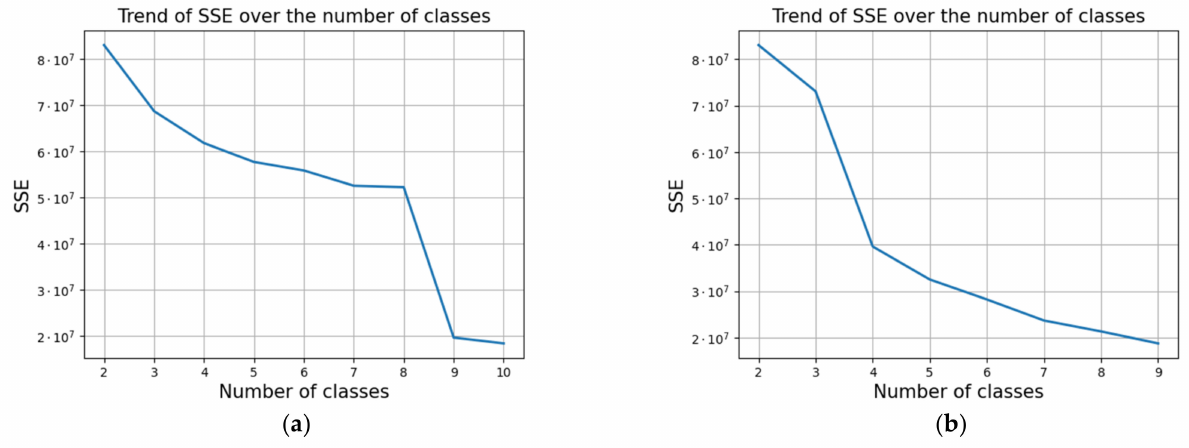
Figure 8. ( a ): estimation of number of clusters on data ranging from 2 to 10 classes using automatic initialization of centroids. ( b ): estimation of number clusters ranging from 2 to 10 classes using manual